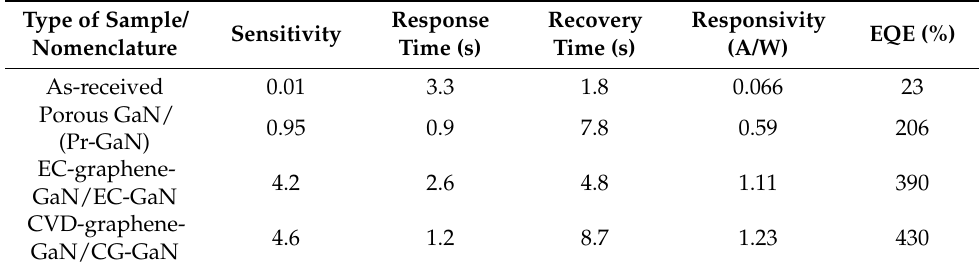
Table 2. Summary of photodetector parameters in this work. Type of